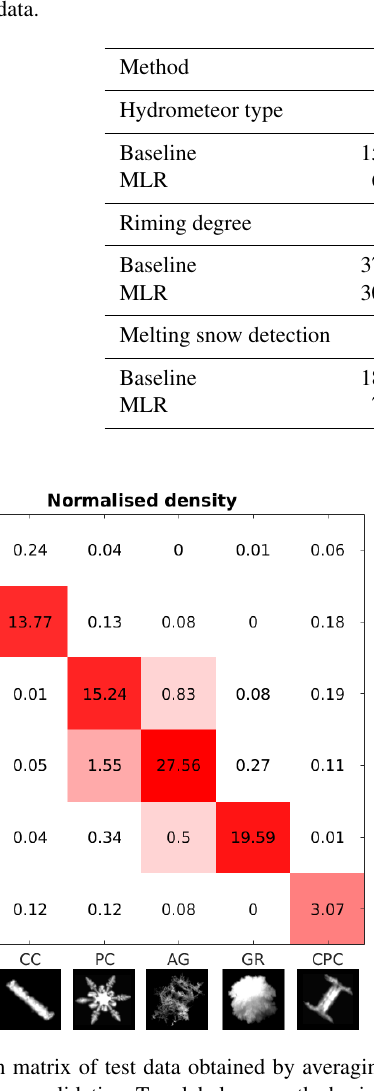
Table 2. Average accuracy scores obtained for the three classification schemes (i.e., hydrometeor type, riming degree and melting snow detection). The numbers indicate the mean ± the standard deviation calculated over 10 instances of 4-fold cross validation and applied on test (i.e., unknown) data.